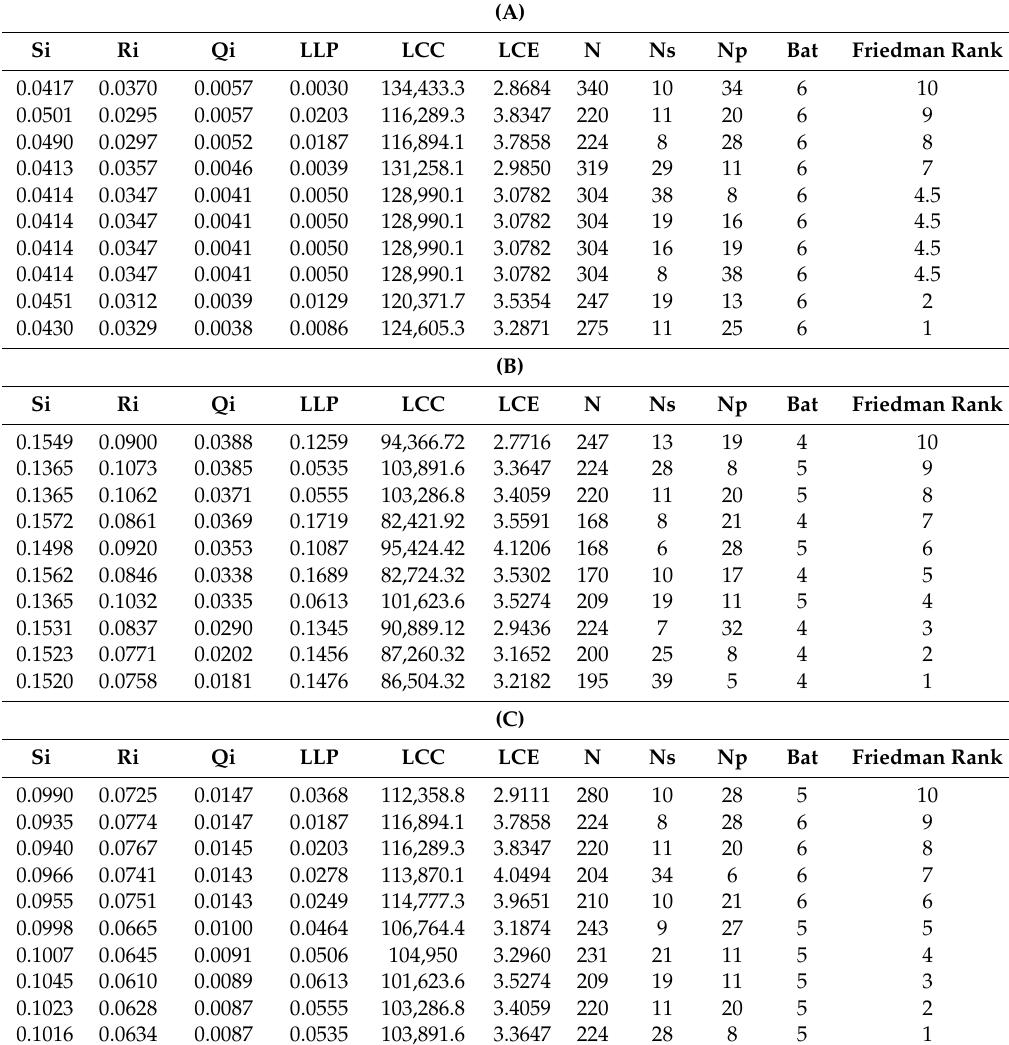
Table 10. ( A ) Results of the AHP-VIKOR method of the SAPV system based on the lithium-ion battery for the first evaluator. (B) Results of the AHP-VIKOR method of the SAPV system based on the lithium-ion battery for the second evaluator. (C) Results of the AHP-VIKOR method of the SAPV system based on the lithium-ion battery for the third